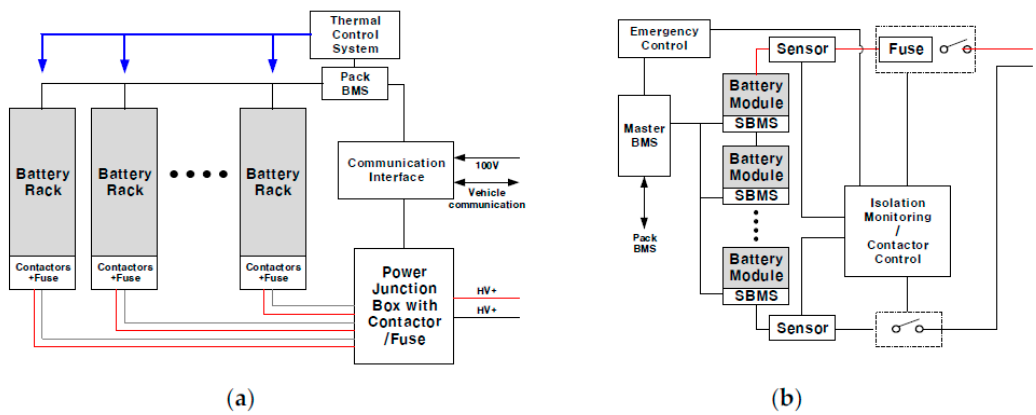
Figure 3. System configuration of a battery pack and a battery rack: ( a ) battery pack; ( b ) battery rack.